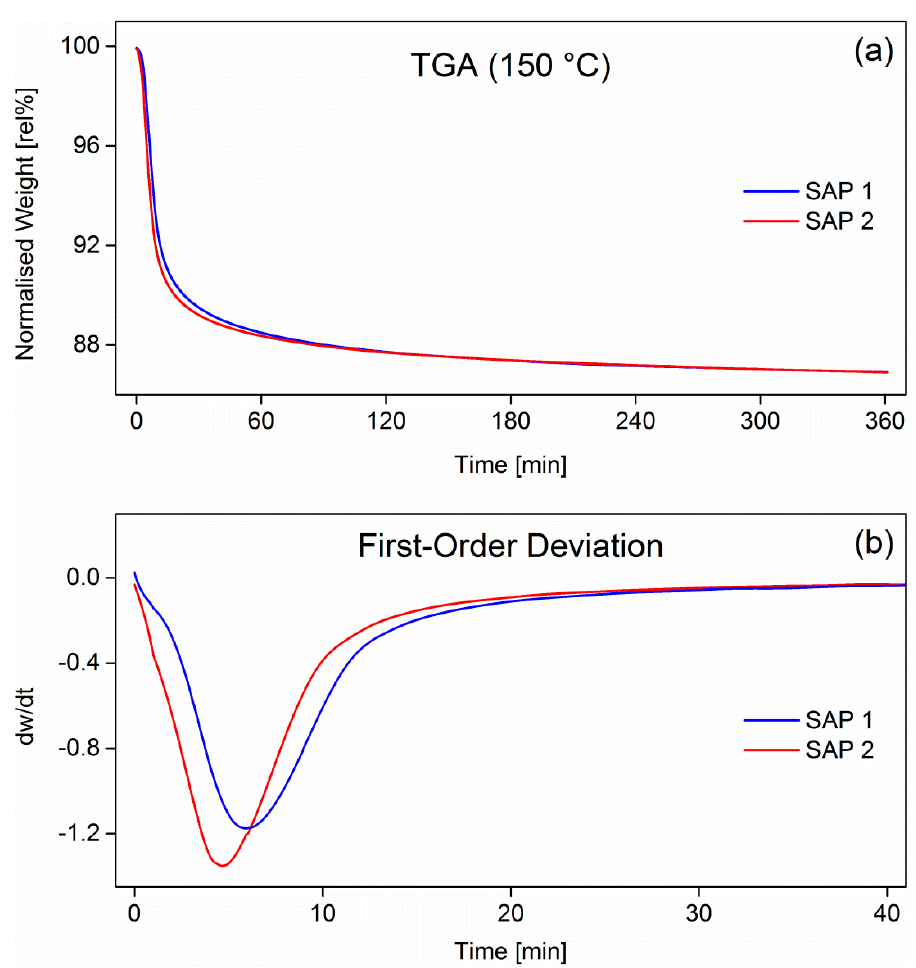
Figure 4. Normalized mass of SAP 1 and SAP 2 measured by TGA ( a ) and the first-order derivative ( b ). Heating rate was 20 K/min. The polymers were held isothermally at 150 °C for 6 h.